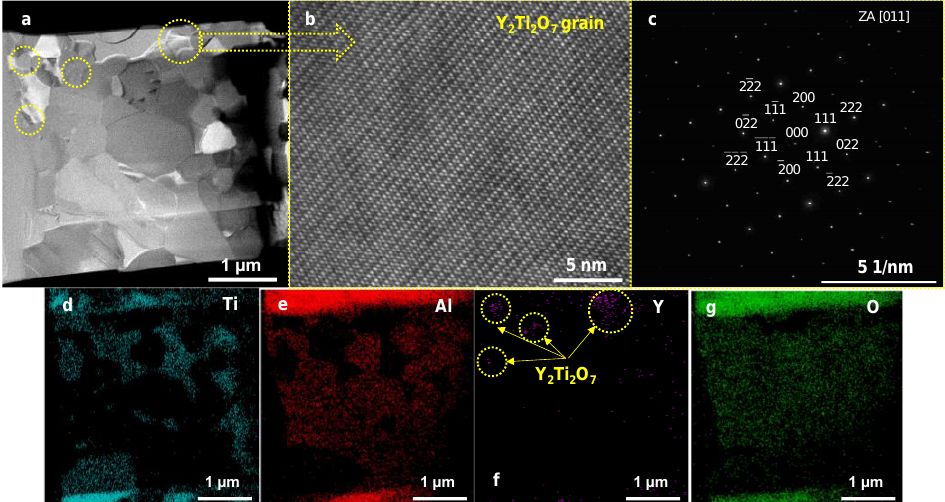
Figure 11. The STEM image of a lamella cut from the oxide layer of a 1.5Y 2 O 3 sample ( a ), HRTEM image of a Y 2 Ti 2 O 7 particle ( b ), and electron diffraction from this grain ( c ); EDS elemental maps of titanium ( d ), aluminum ( e ), yttrium ( f ), and oxygen ( g ).